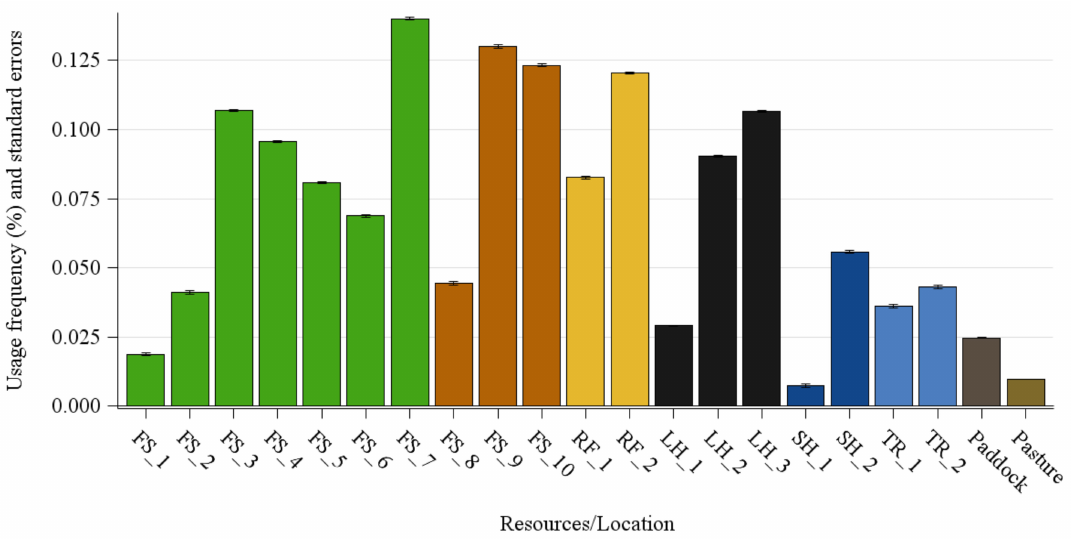
Figure 5. Usage frequency (%) and standard errors of different locations/resources of the farm divided into feed stalls (FS/green, orange), straw racks (RF/yellow), lying halls (LH/black), shelters (SH/dark blue), watering troughs (TR/light blue), paddock (dark brown) and pasture (light